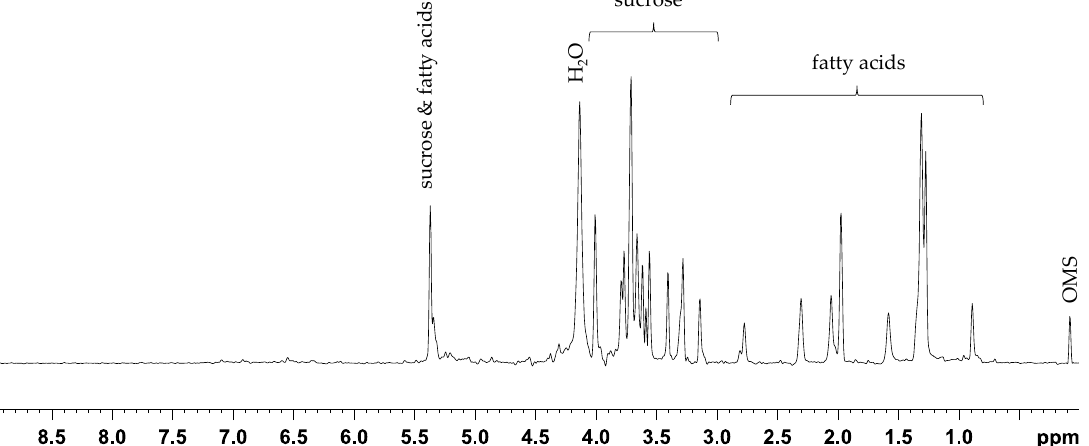
Figure 4. Representative PSYCHE spectrum (400 MHz) of the mid-polar walnut extract (acetonitrile- d 3 /methanol- d 4 (method B)) showing the fatty acids in the aliphatic region as well as carbohydrates such as sucrose. Hardly any signals can be detected in the aromatic region of the spectrum.